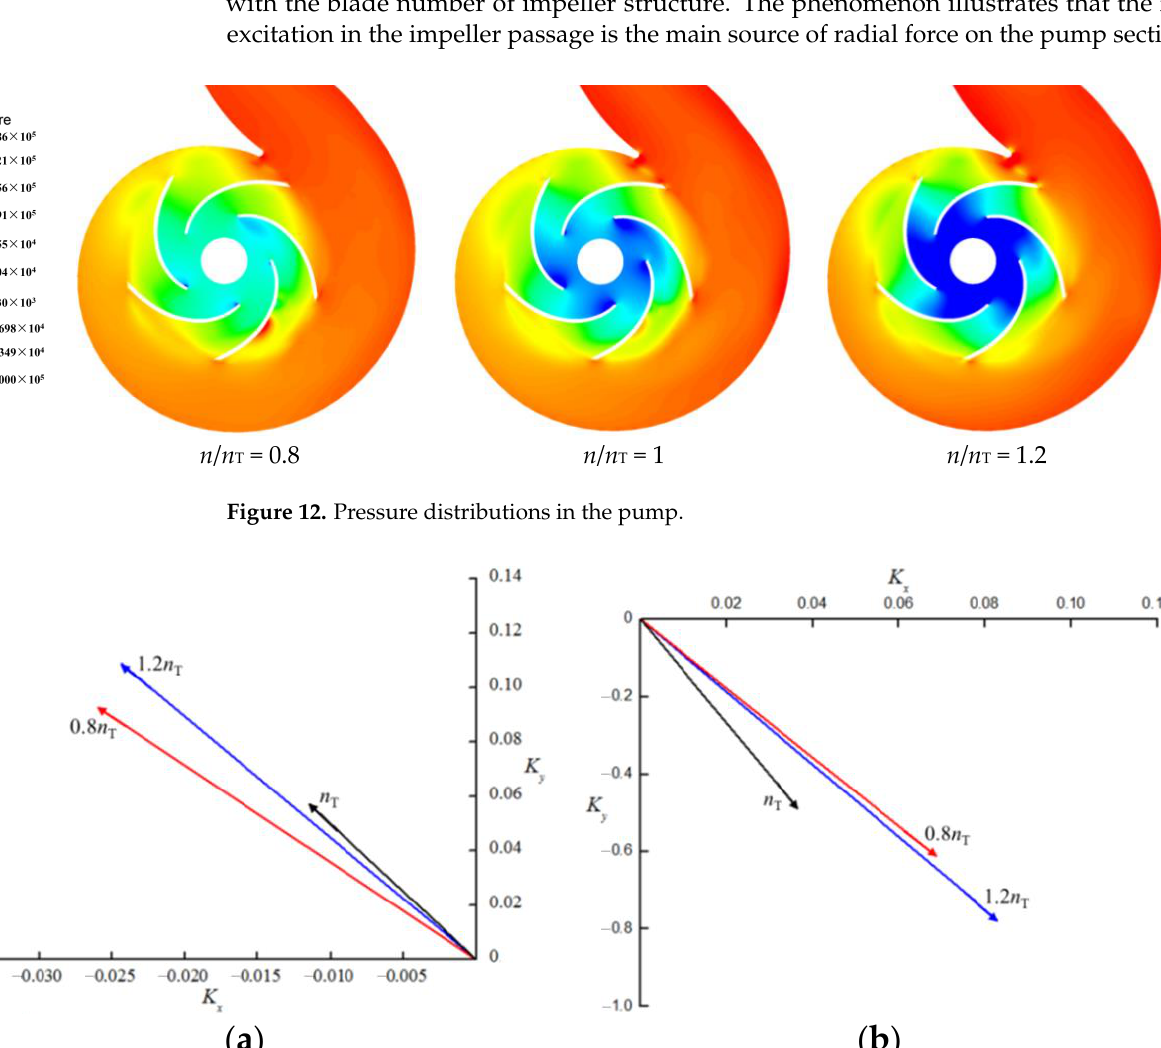
Figure 13. Initial direction and magnitude of radial hydraulic force. ( a ) On the impeller; ( b ) On the volute.